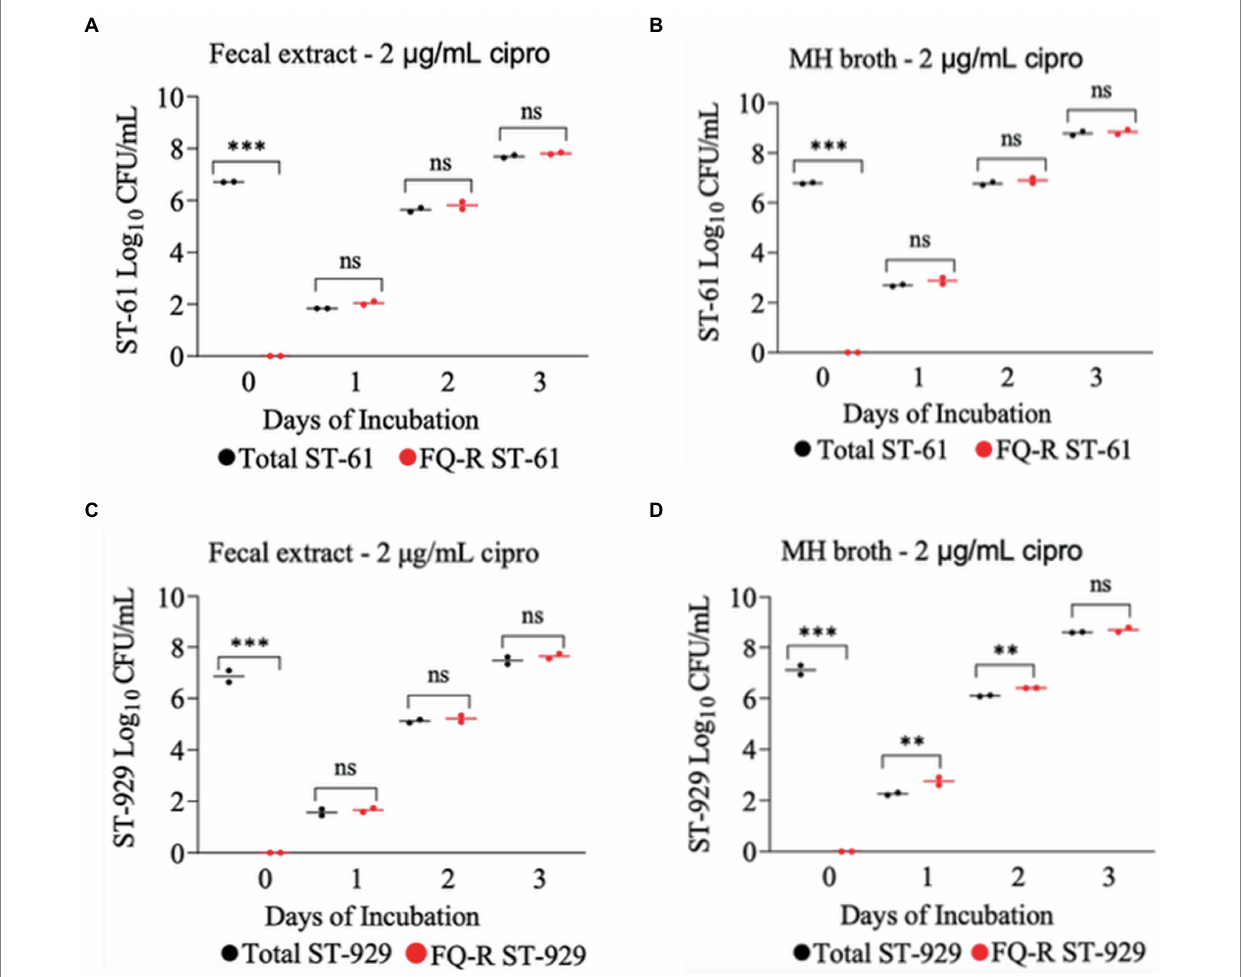
FIGURE 5 Development of FQ-resistant C. jejuni mutants (shown as red dots) from FQ-susceptible strains (ST-61, and ST-929) grown in bovine fecal extract (A,C) and MH broth (B,D) supplemented with 2 μ g/mL of ciprofloxacin. The initial bacterial cell density (day 0) of each inoculum was 10 7 CFU/mL. Black dots denote total (susceptible + resistant) colonies. Each dot represents the log 10 CFU/mL of each strain at a given time (horizontal bars represent the mean log 10 CFU/mL of three replicates). The number of bacterial colonies was measured on days 0, 1, 2, and 3 of incubation. The detection limit of the culture was ~ 4 CFU/mL medium. The experiment was repeated twice, and the results of one representative experiment are